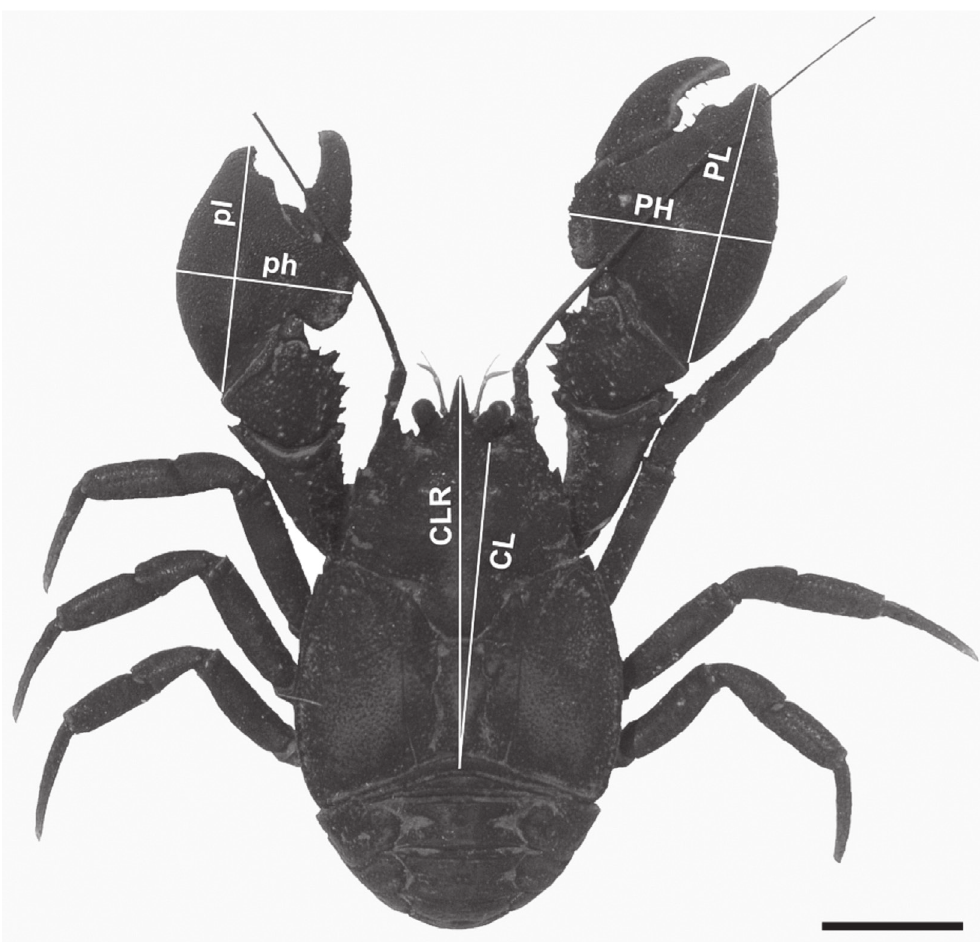
Figure 1. Aegla castro . Live male specimen. Carapace measurements: carapace length from orbital sinus to posterior border, rostrum excluded (CL); carapace length with rostrum included (CLR). Chelae measurements: propodus length (pl) and propodus height (ph) of minor chela; propodus length (PL) and propodus height (PH) of major chela. Scale bar = 10